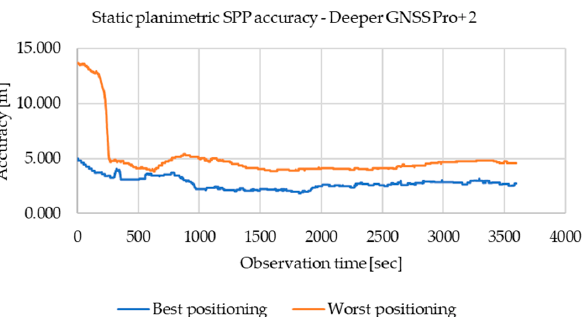
Figure A1. Accuracy (best and worst) in real-time planimetric static SPP of the Deeper Smart Sonar CHIRP+ during 3600 s.